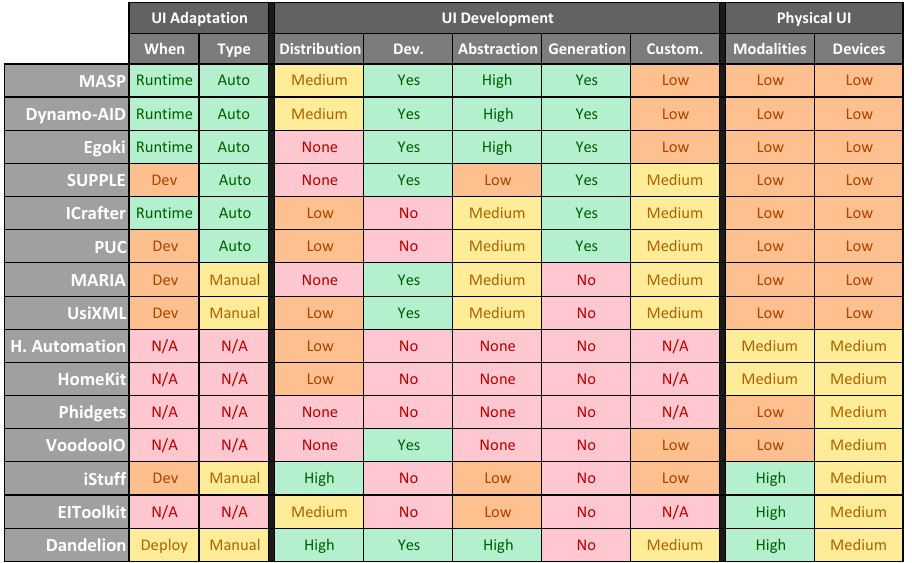
Figure 8. Feature comparison between the different solutions analyzed.